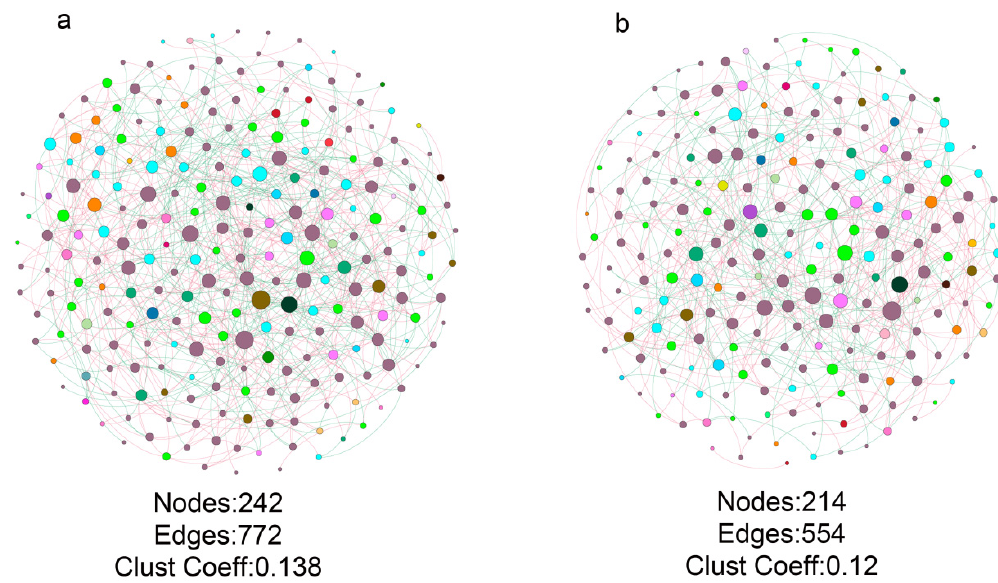
Figure 4. Fungal networks of healthy ( a ) and bacterial wilt-diseased ( b ) tomato plant rhizospheres. The number of nodes and edges and the clustering coefficients are shown below the networks. The node sizes represent the link numbers. Pink and blue lines represent negative and positive associations, respectively.